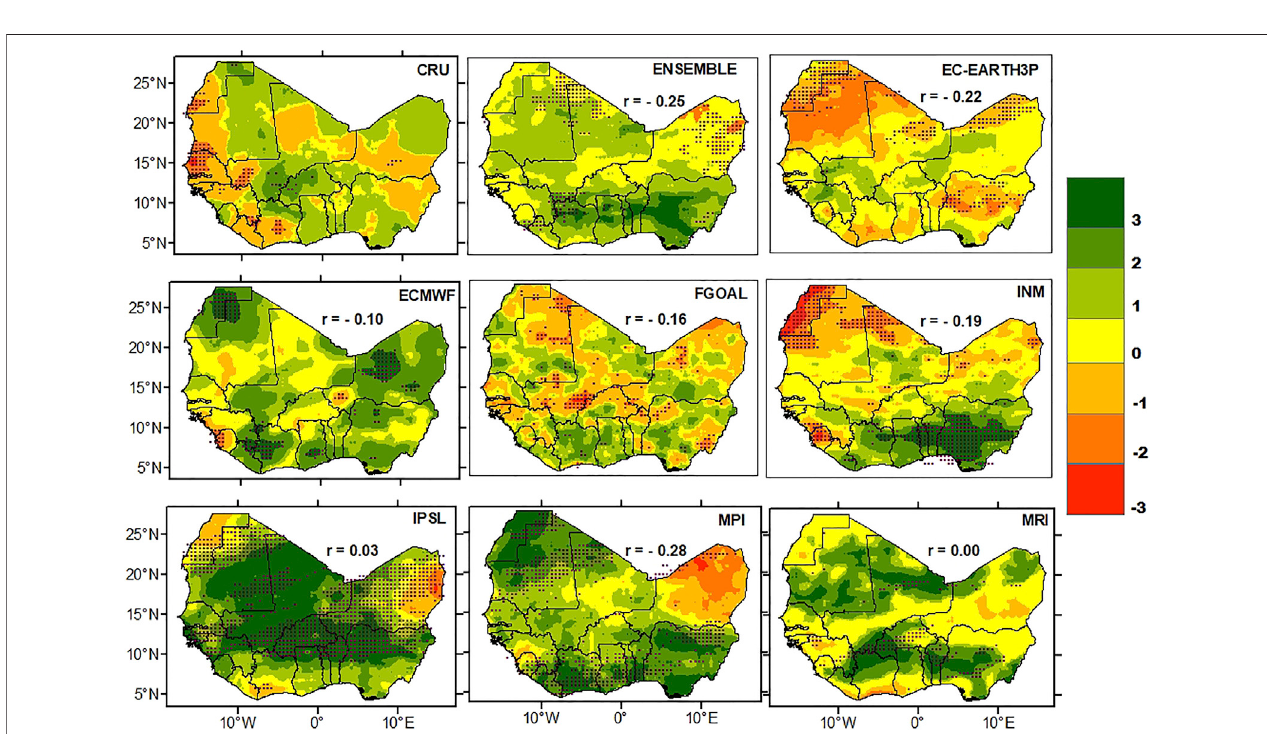
FIGURE 9 | Same as Figure 8 but for SPEI-3.